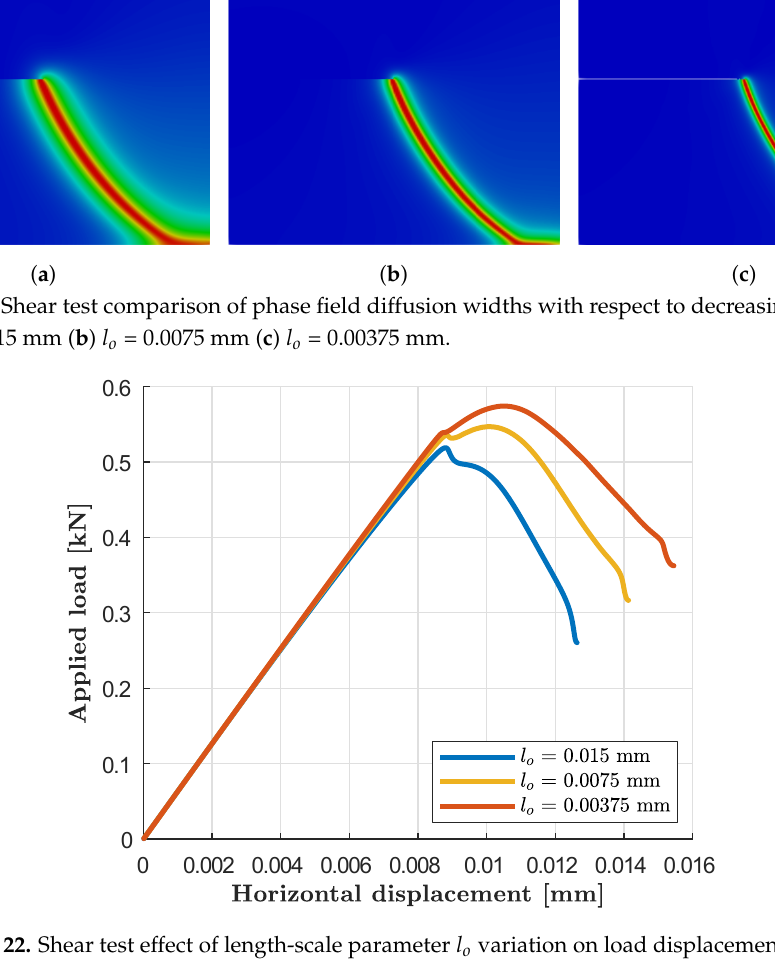
Figure 22. Shear test effect of length-scale parameter l o variation on load displacement